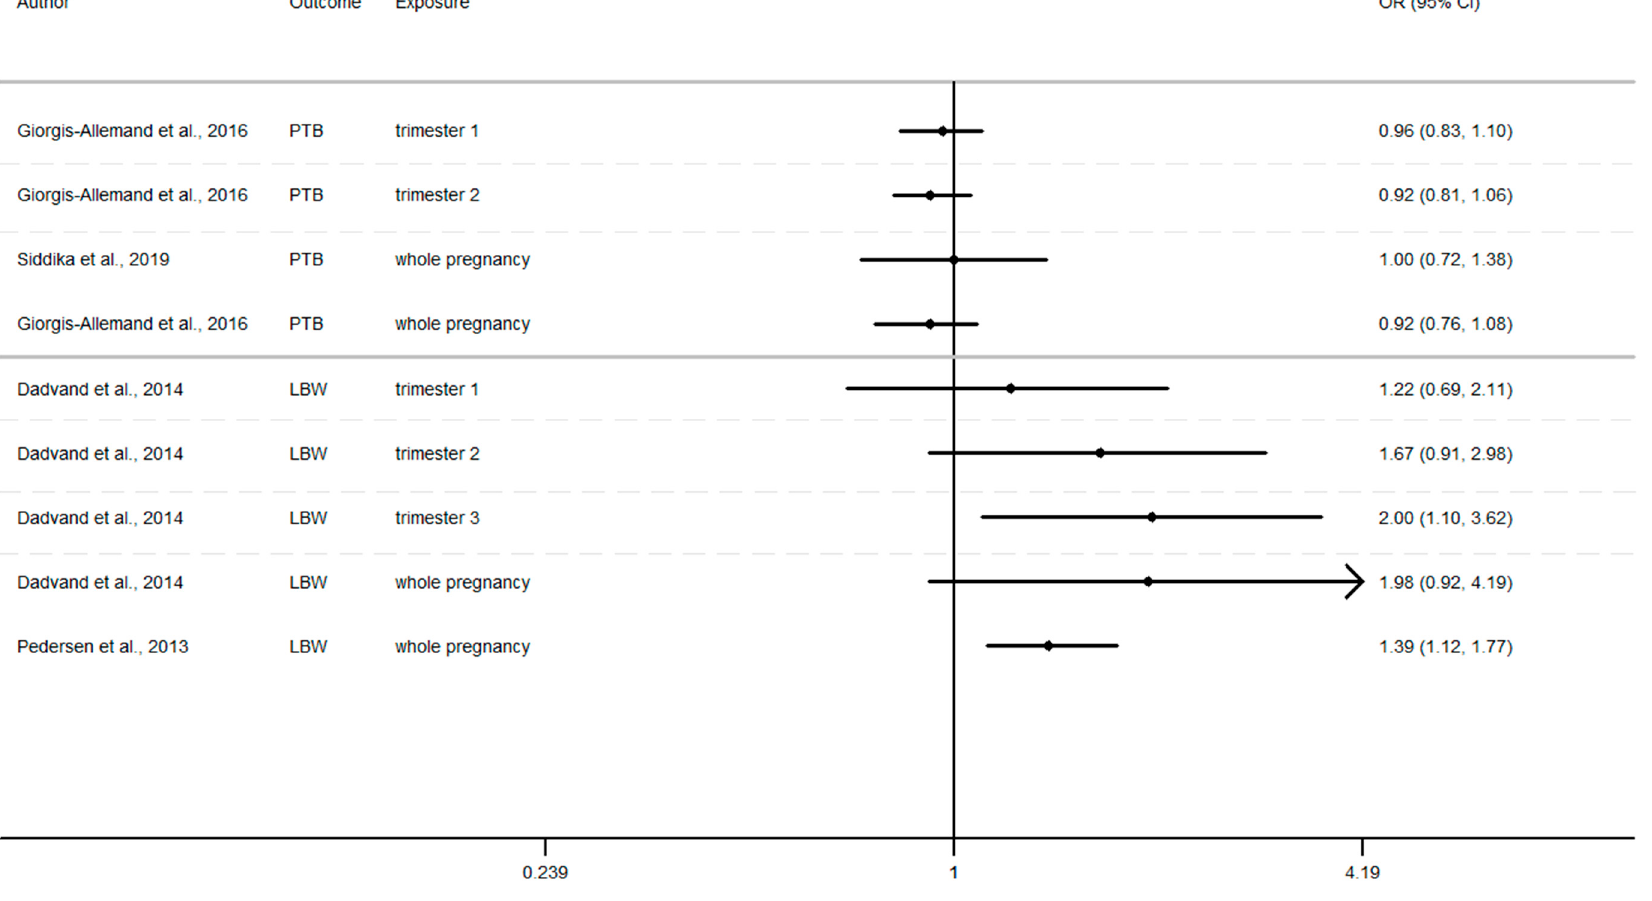
Figure 4. Risk of birth outcome for PM 2.5 exposure during different windows of exposure during pregnancy.